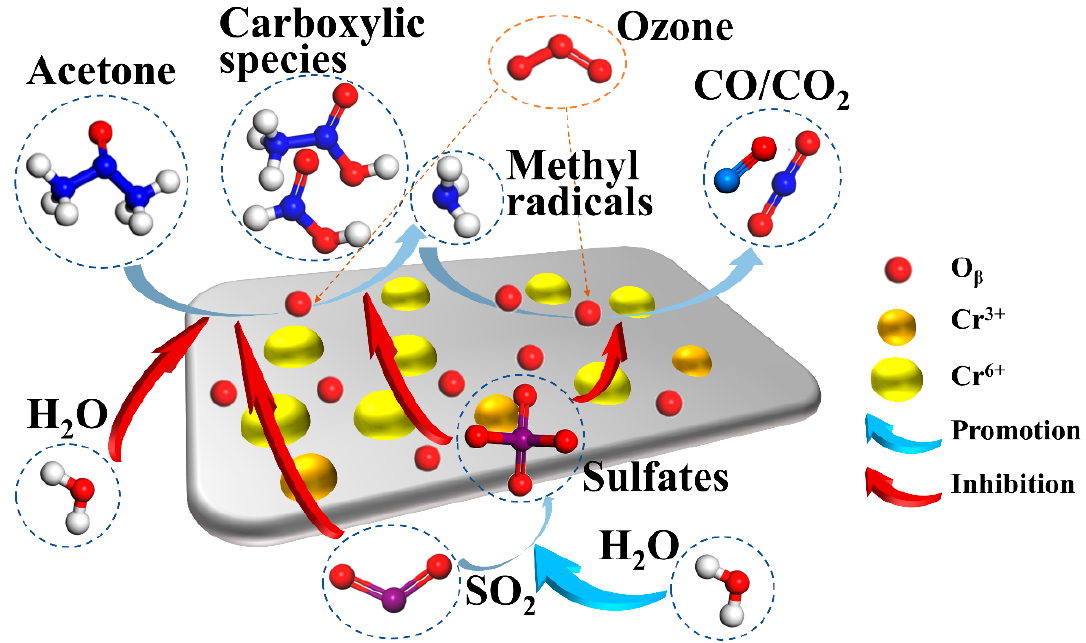
Figure 8. Mechanisms of acetone decomposition over Cr1.5% and inhibition effects of SO 2 /H 2 O.